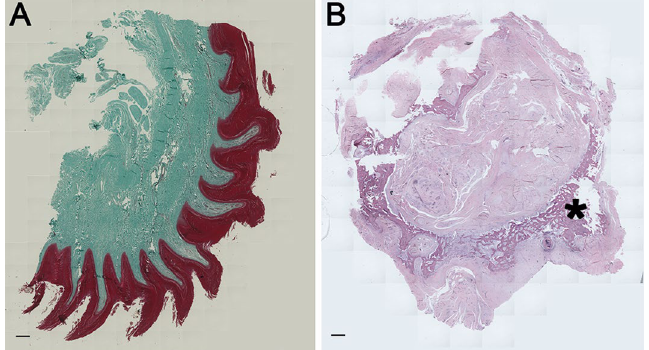
Figure 2. ( A ) Masson Trichrome staining of a stump skin biopsy: Shown is the specific skin architecture of the vulture’s stump in a cross-section. Red indicates the epithelium and cyan the subcutaneous tissue. The osseointegration device is surrounded by this tissue and provides a safe enclosure of the skin penetrating element. ( B ) HE-Staining of the tarsometatarsus bone showing cortical bone (see asterisk) filled with connective tissue and cartilage, surrounded by thin cortical bone in a cross-section. Bar indicates 1